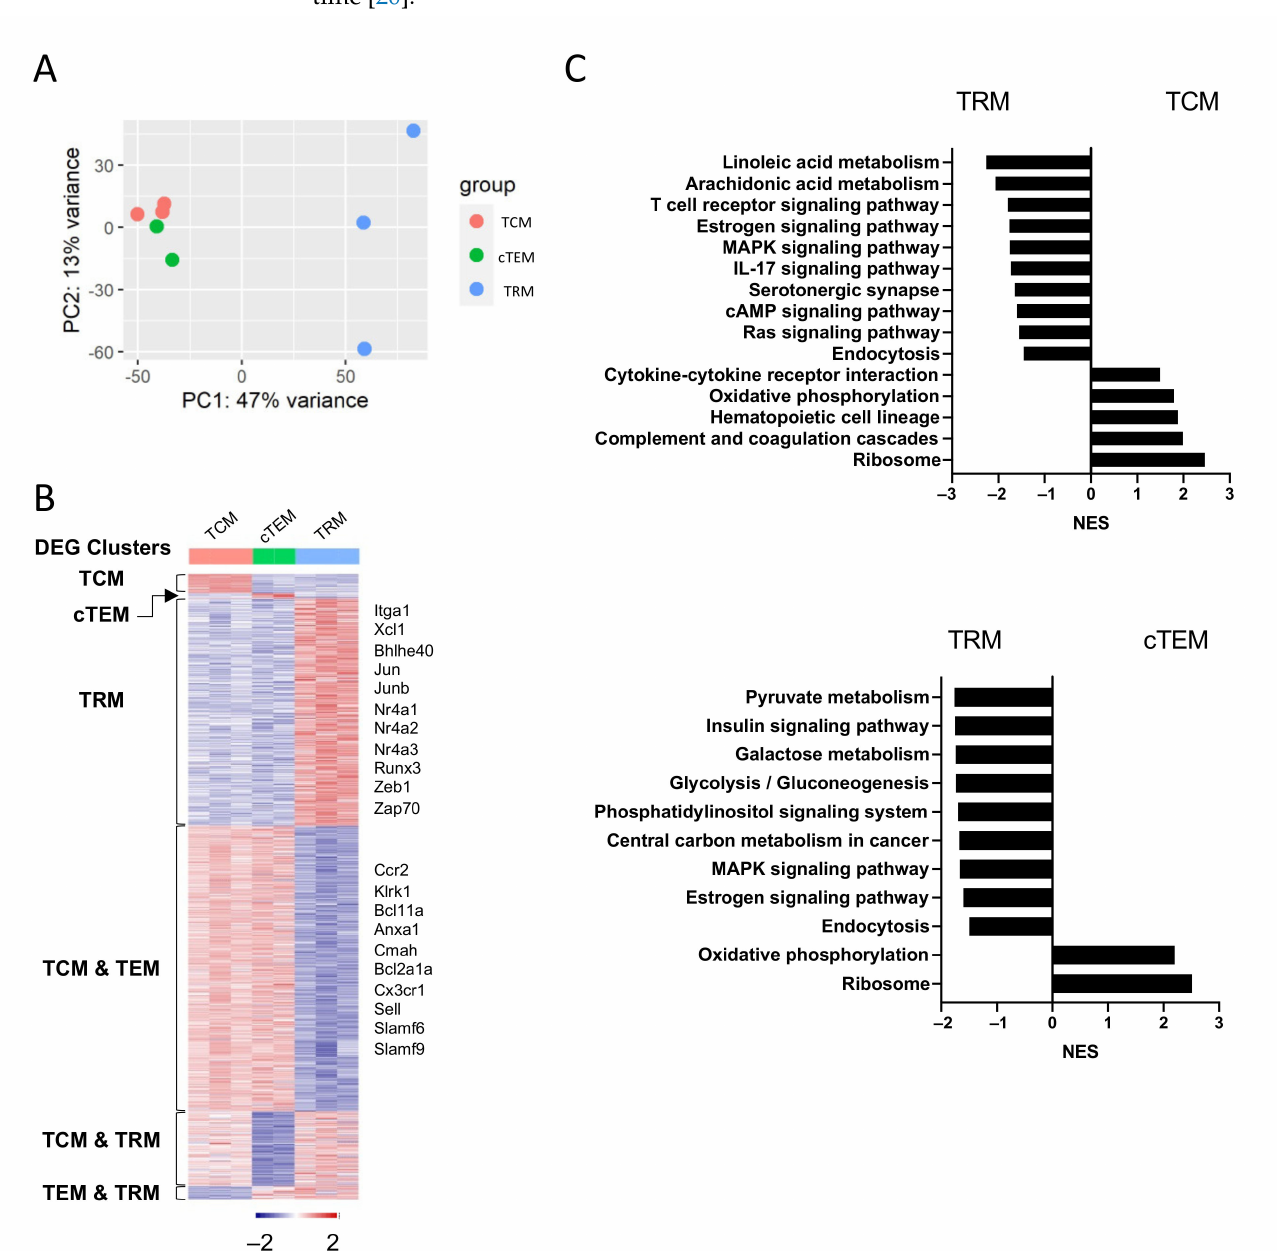
Figure 3. Bulk RNA-seq reveals the unique transcriptional profiles of TRM compared with TEM and TCM: ( A ) Principal component analysis (PCA) plot showing the top two principal components distinguishing the transcriptional profiles of three populations. ( B ) Heatmap showing the significantly ( p .adjust < 0.05) differently expressed genes in each population. ( C ) Gene set enrichment analysis (GSEA) using the KEGG database revealed pathways up or downregulated (adjusted p -value < 0.05) in TRM compared with TCM or